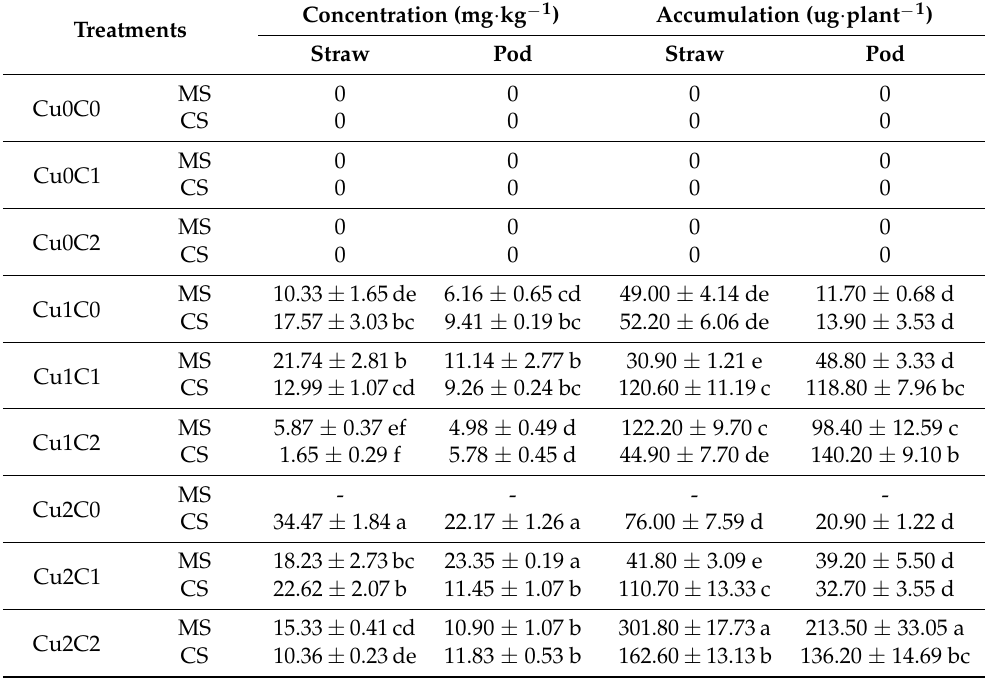
Table 2. Cu content and accumulation in